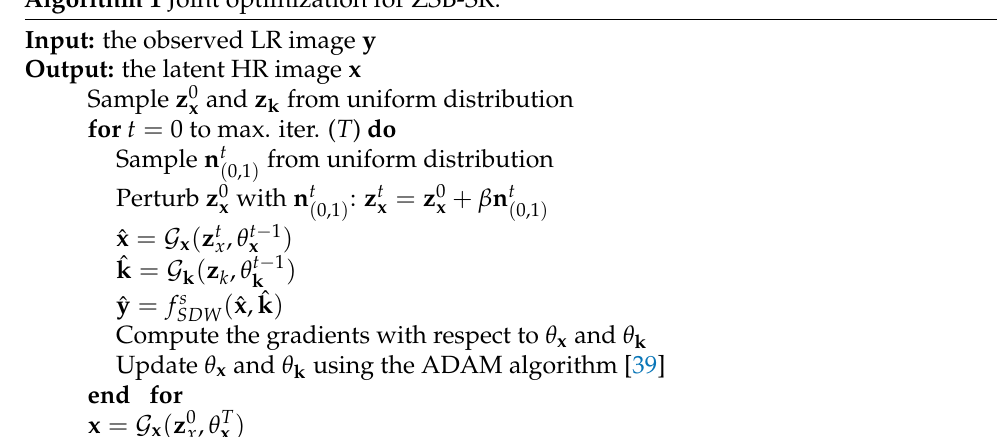
Algorithm 1 Joint optimization for